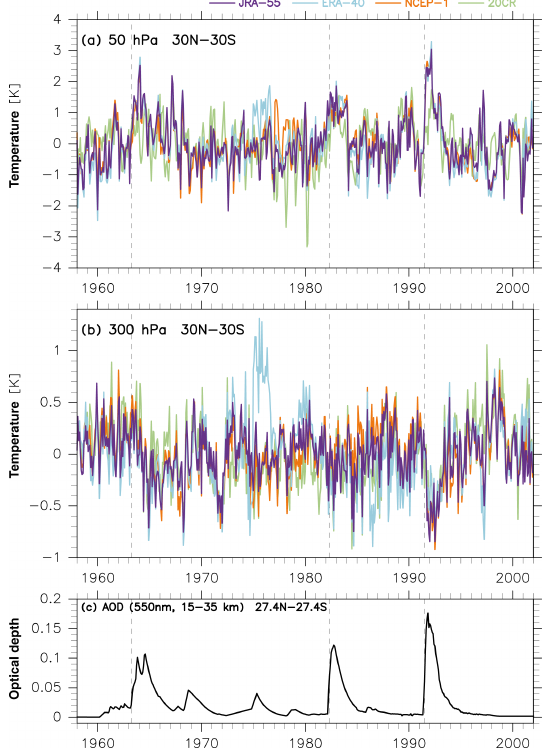
Figure 7. As in Fig. 3 but for the 1958–2001 regression analysis from four reanalysis data sets. Vertical dotted lines indicate the start- ing date of the three volcanic eruptions.